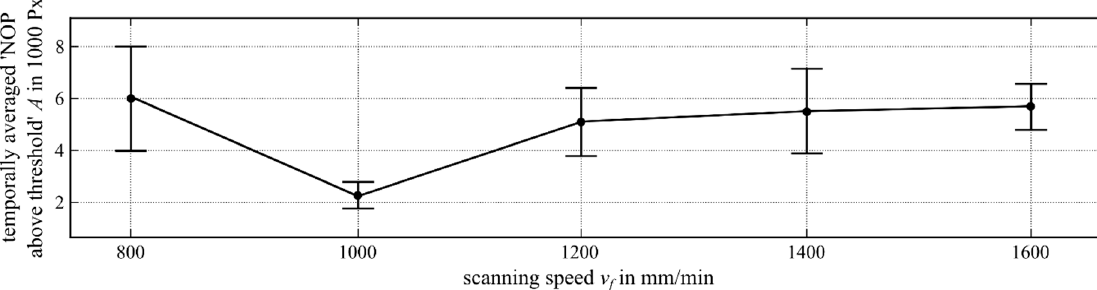
Figure 7. Temporally averaged NOP (intensity threshold 948 digits) over the scanning speed variation.